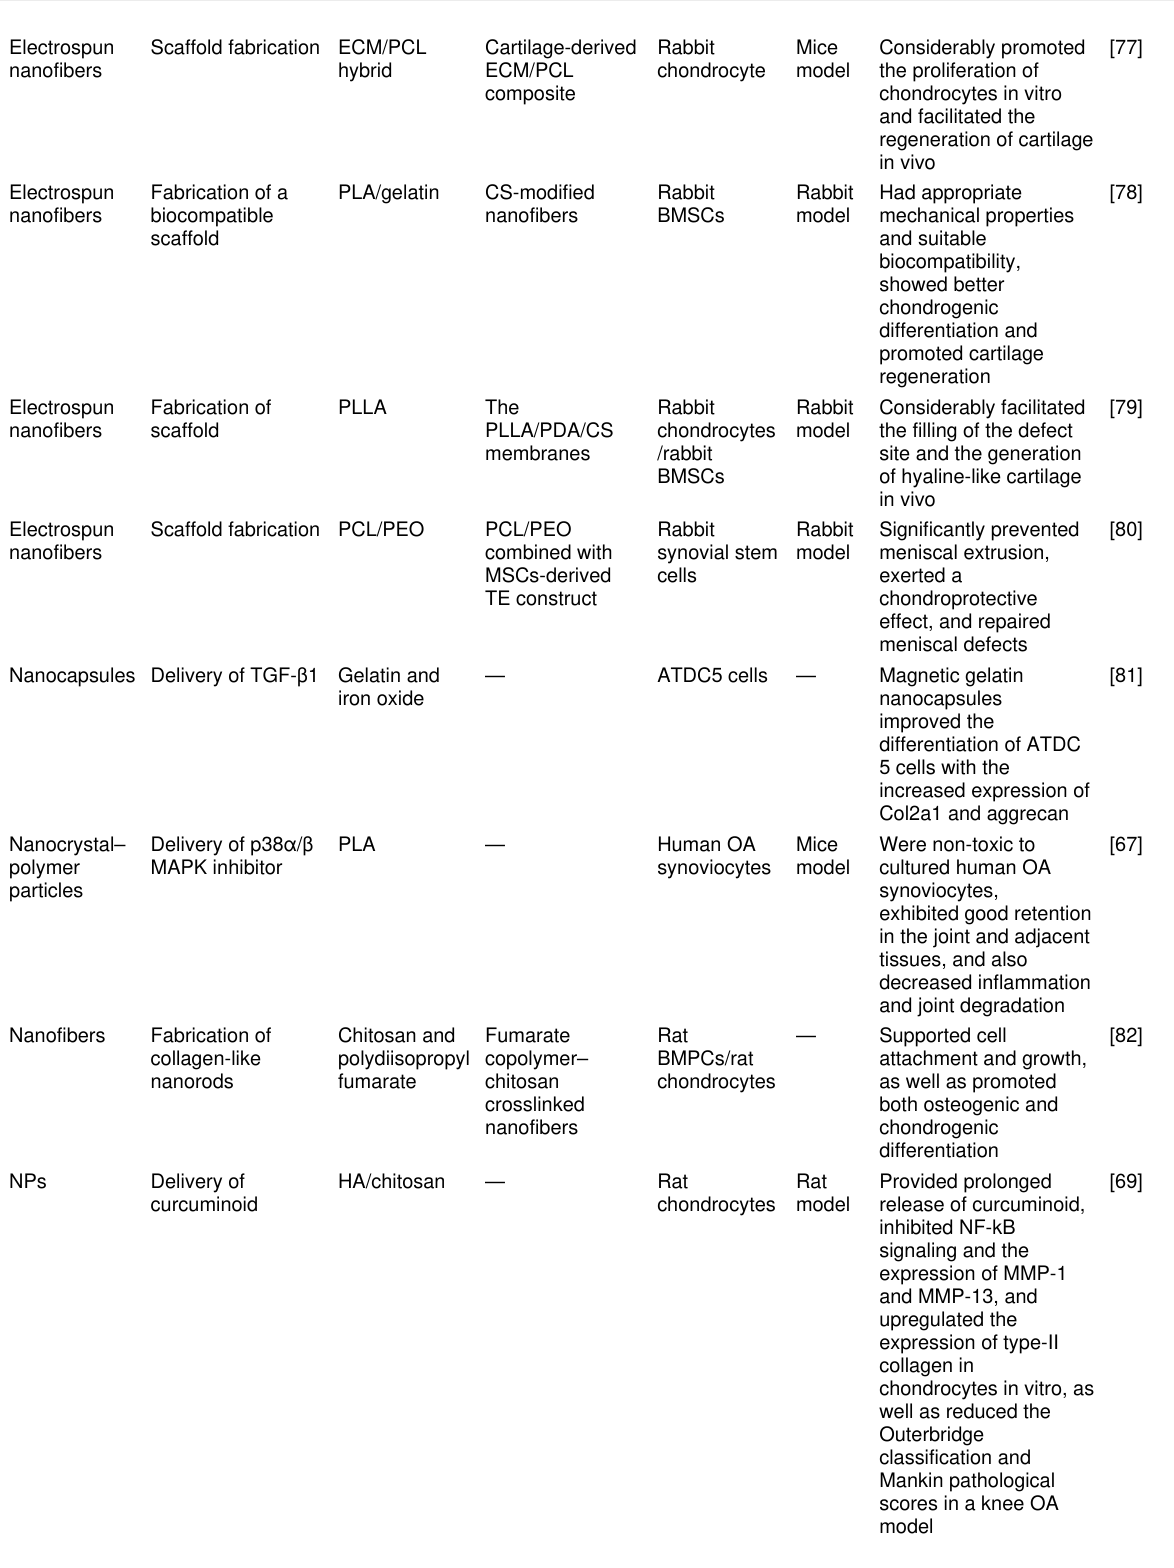
Table 1: Summary of the recent studies on microscale/nanoscale materials used for the fabrication of cartilage tissue engineering (TE) structures. (continued)